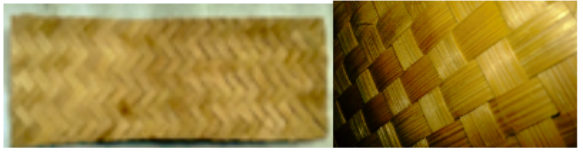
Figure 1: Woven Bamboo Mat Derived from Local